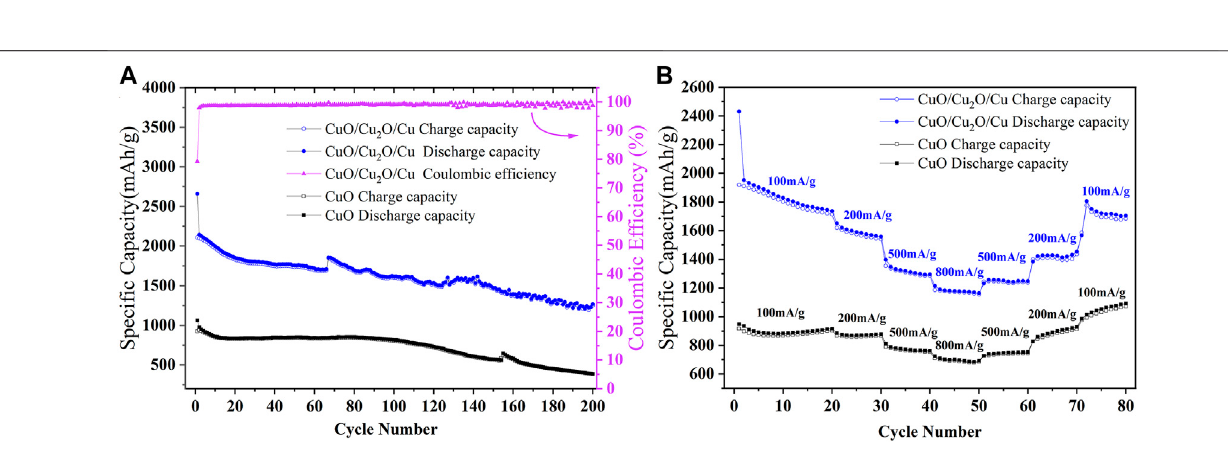
Frontiers in Chemistry |